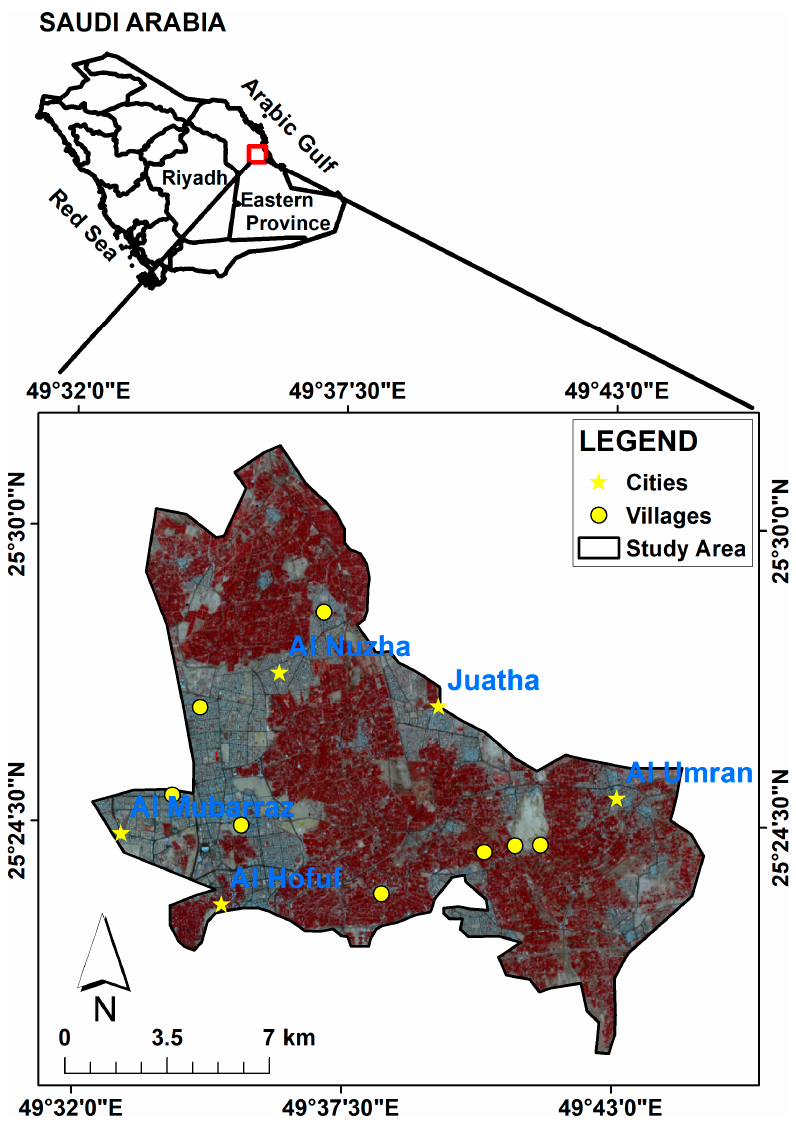
Figure 2. The geographical location of the study area. Agricultural activity is a principal livelihood for the citizens of Al-Ahsa, and mostly relies on a water supply from a number of springs in addition to underground sources. Alghannam and Al-Qahtnai [34] documented that the Al-Ahsa Oasis is a crucial agricultural area for the eastern region of the Kingdom. The overall cultivated area is around 8000